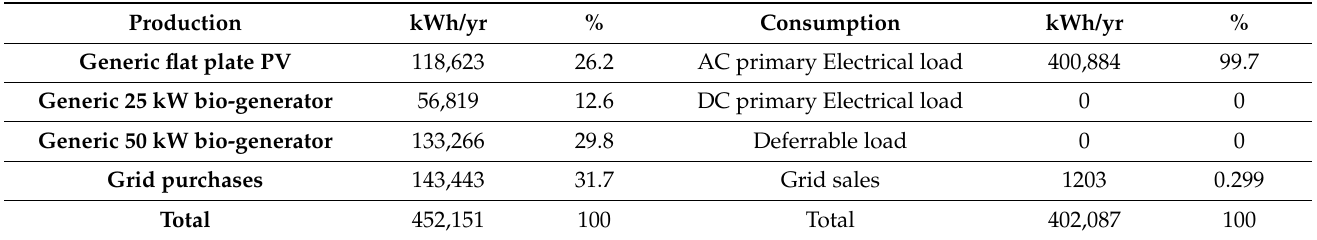
Table 5. Electricity generated and consumed by the power system